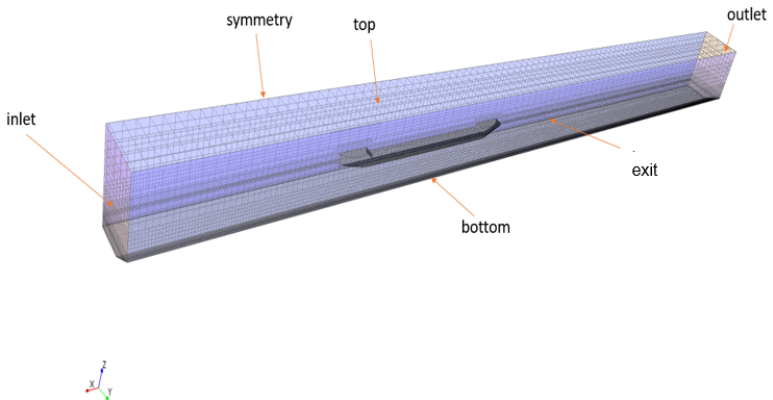
Figure 5. Computational domain of the validation simulation.